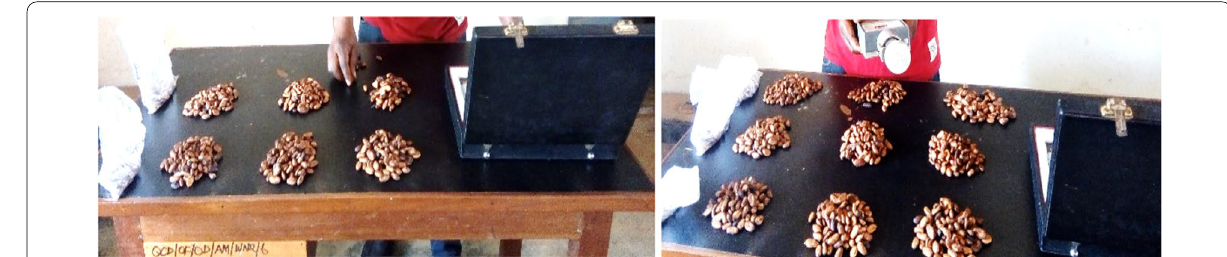
Fig. 2 Bean count and determination of moisture content with Moisture Meter Aquaboy